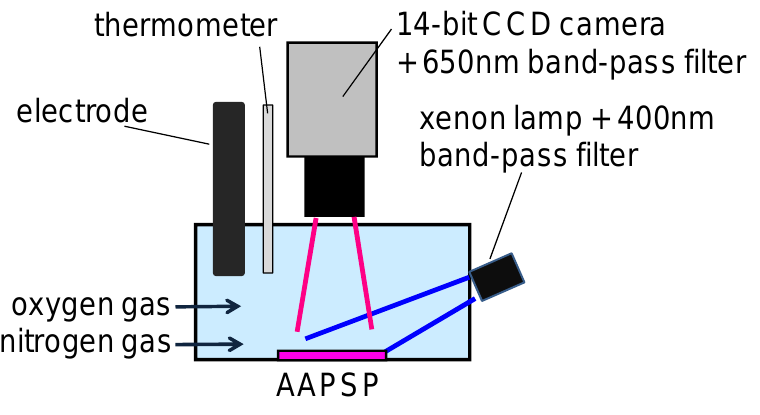
Figure 6. Schematic description of oxygen calibration setup in